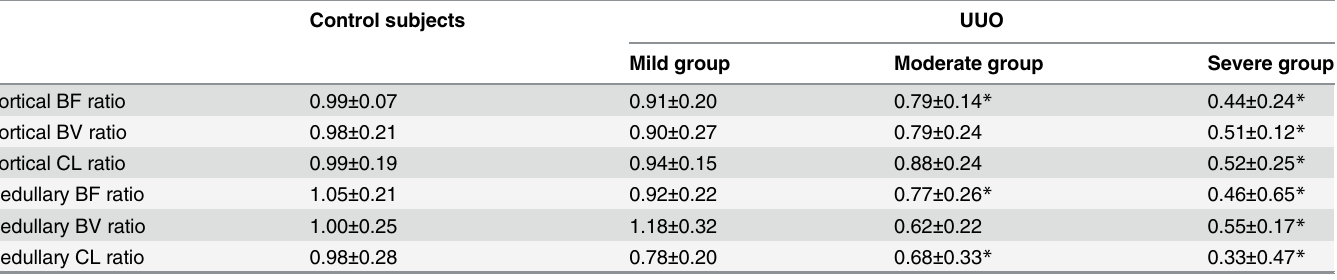
Fig 3. BF, BV and CL maps from control subjects and the three groups of UUO. The perfusions of both kidneys were uniform in control subjects and renal cortex showed an intact red ring. For UUO patients, BF, BV and CL maps showed dilation of collecting system in the obstructed kidney (arrow) and normal contralateral kidney. The renal cortex from obstructed kidney was less continuous and local yellow or blue areas were observed in the perfusion maps. BF, blood flow; BV, blood volume; CL, clearance. doi:10.1371/journal.pone.0122454.g003 Table 2. Mean cortical or medullary BF ratio, BV ratio, and CL ratio between the obstructed and contralateral kidneys in UUO patients and between the left and right kidneys in control